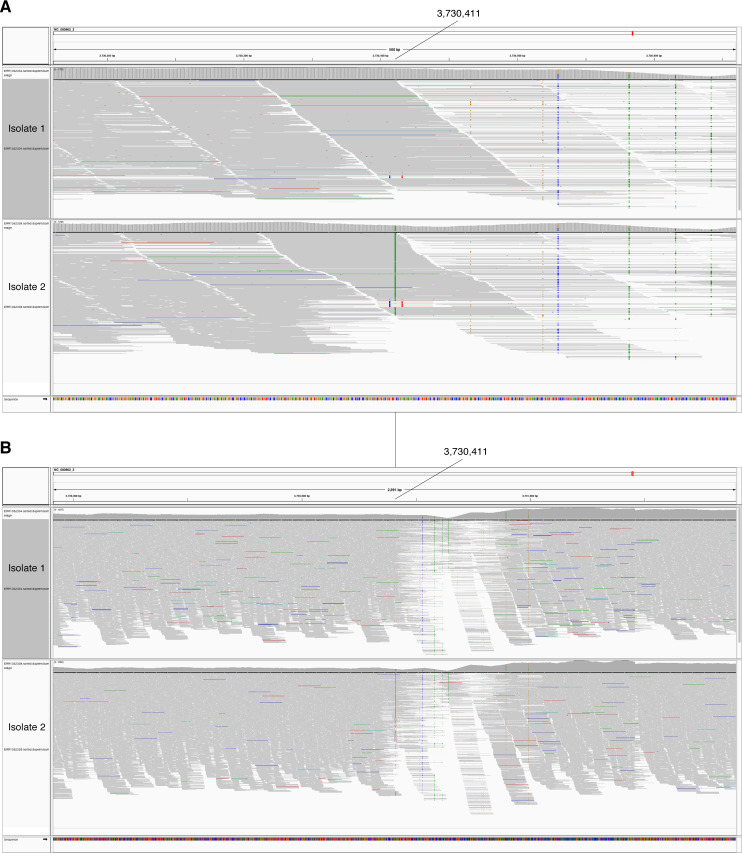
In-host SNP detected in PPE54.IGV (Thorvaldsdóttir et al., 2013) image of BAM alignment (reads sorted by start location) for longitudinal clinical isolates that were cultured from sputum collected from patient P09 (Trauner et al., 2017). (A) 500 and (B) 3000 basepair windows centered at reference position 3730411. Isolate 1 is the BAM alignment for the isolate collected first and the reference position 3730411 matches the reference allele (G). Isolate 2 is the BAM alignment for isolate collected 24 weeks after isolate 1 and reference position 3730411 supports an alternate allele (A).